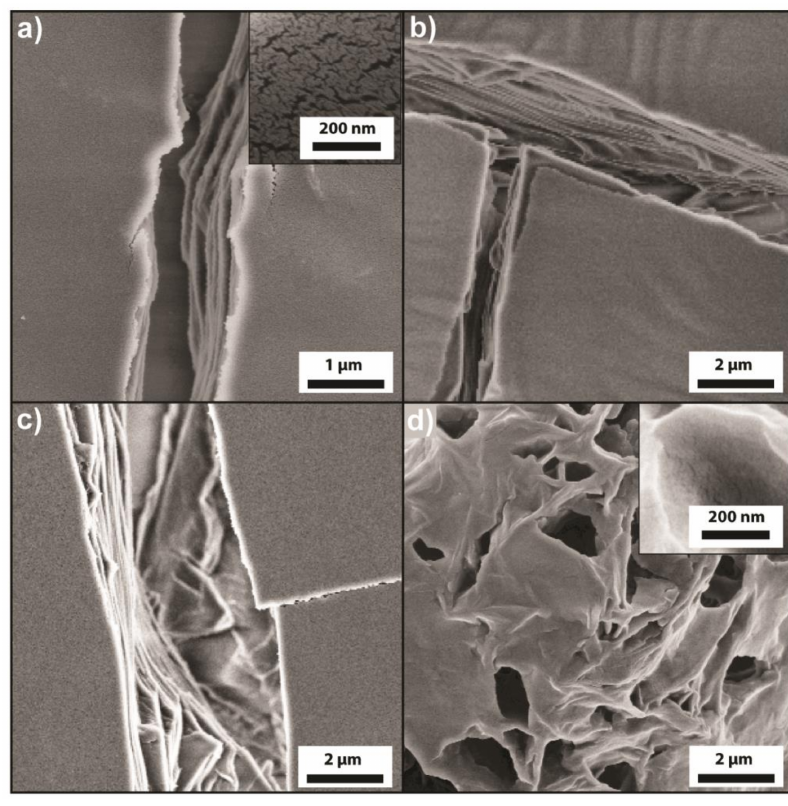
Figure 6. Scanning electron microscopy (SEM) imaging of freeze dried hydrogel samples: ( a ) PVP 41k - b -POEGMA 22k (3.3 wt.%)/ α -CD (10.4 wt.%) initial hydrogel, ( b ) PVP 41k - b -POEGMA 22k (3.3 wt.%)/ α -CD (10.4 wt.%) after heating to 65 ◦ C and cooling to 25 ◦ C, ( c ) PVP 41k - b -POEGMA 22k (3.3 wt.%)/ α -CD (10.4 wt.%) after heating to 85 ◦ C and cooling to 25 ◦ C and ( d ) POEGMA 22k (1.7 wt.%)/ α -CD (10.4 wt.%) after heating to 85 ◦ C and cooling to 25 ◦ C.